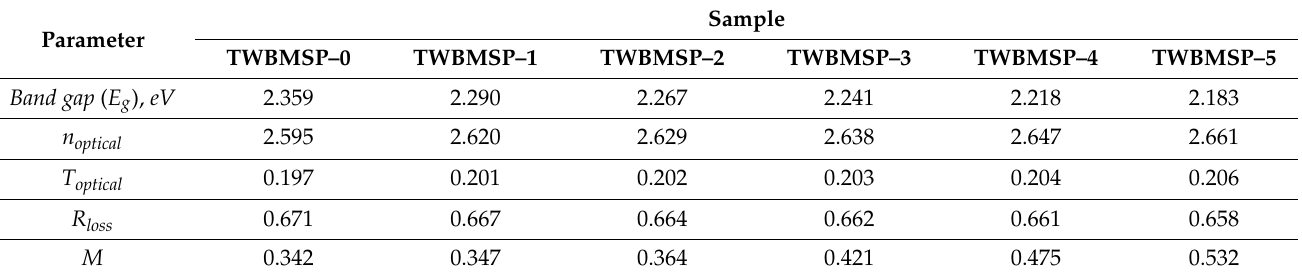
Table 2. Optical characteristics of the studied